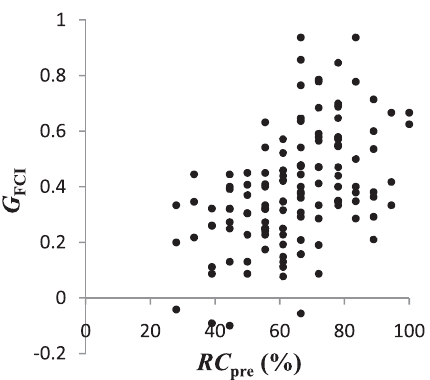
FIG. 6. Scatter plot for the students’ ( n ¼ 131 ) FCI prescores ( FCI pre ) and the single student normalized FCI gain ( G FCI ). Spearman’s rank correlation is 0.33 ( p < 0 : 001